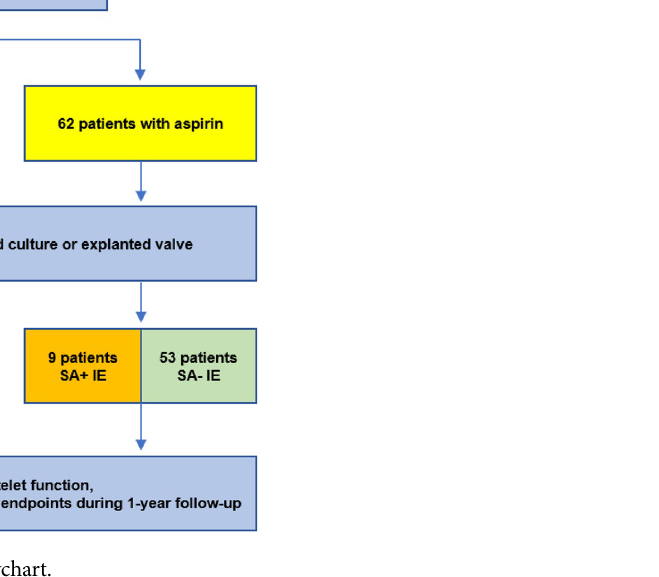
Figure 1. Study design as